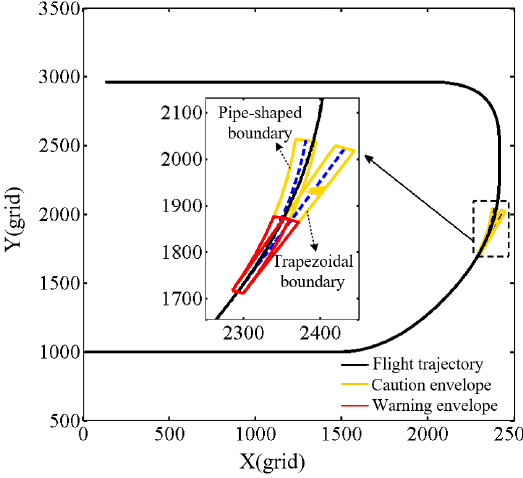
Figure 9. Comparison results of the two methods. ( a ) Horizontal alert; ( b ) traditional method verti- 251 cal alert; ( c ) RFLTA method vertical alert.